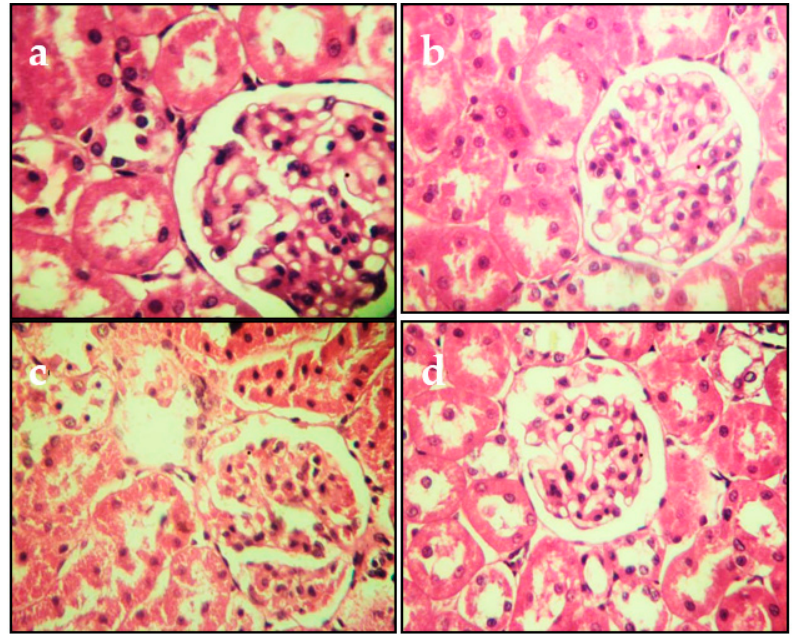
Figure 5. Representative photomicrographs of section from kidney. ( a ) Control group. ( b ) Juice extract (250 mg/kg)-treated rat kidney showing normal appearance of glomeruli. ( c ) CdCl 2 (1 mg/kg)-treated rat kidney showing tubule glomerular degeneration. ( d ) CdCl 2 + juice extract (250 mg/kg)-treated rat kidney showing near-normal kidney architecture and normal histological features. All sections were stained with hematoxylin/eosin; 400× for all panels.